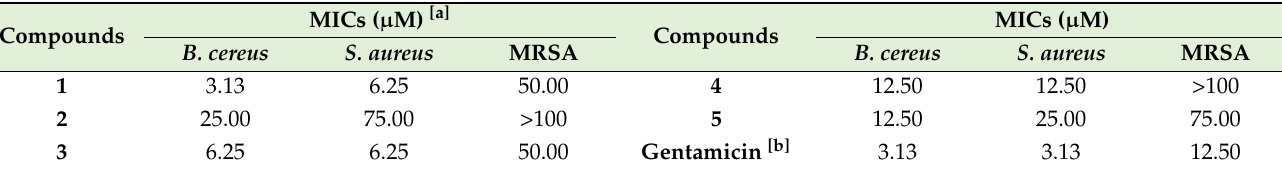
Table 2. MIC values of compounds 1 – 5 against test bacteria.